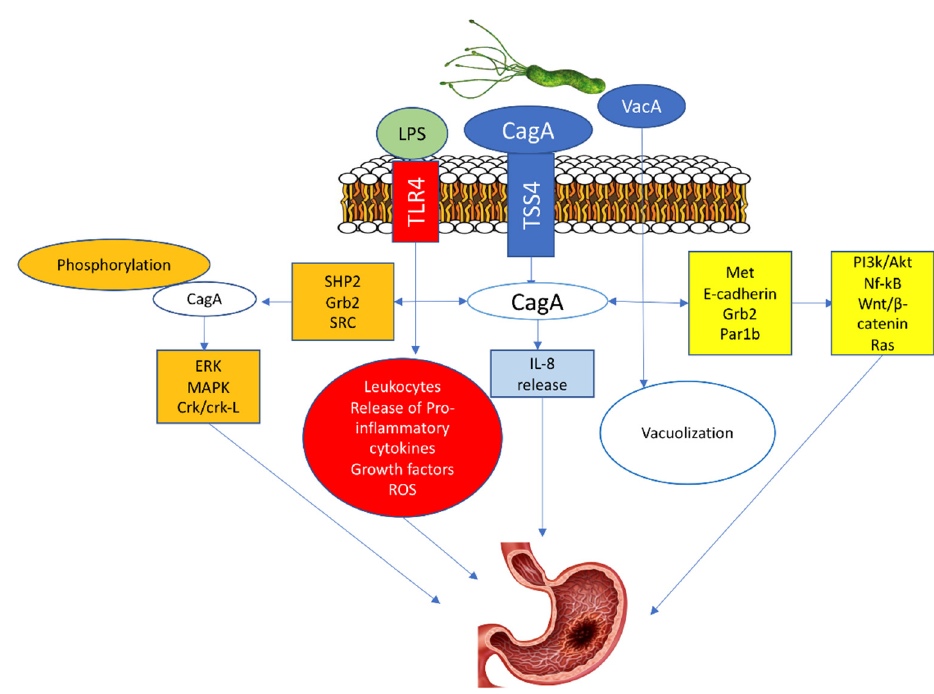
Figure 2. H. pylori -induced Gastric cancer.